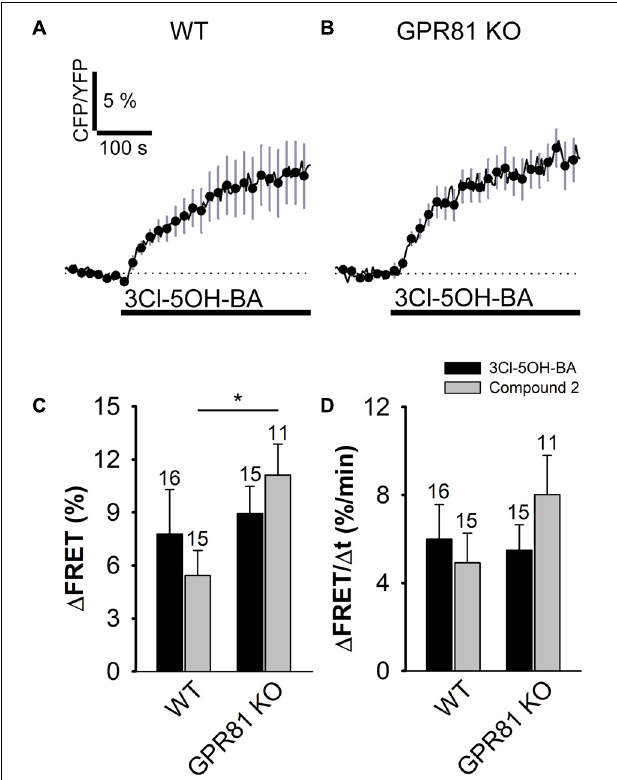
FIGURE 2 | Stimulation with 3Cl-5OH-BA and Compound 2 elicits persistent increase in [cAMP] i in WT and GPR81 KO mice astrocytes expressing the FRET nanosensor Epac1-camps. (A,B) Mean normalized time-courses of the Epac1-camps FRET ratio signal after stimulation with 3Cl-5OH-BA (0.5 mM) in (A) WT ( n = 16) and (B) GPR81 KO ( n = 15) cultured mouse astrocytes at t = 100 s (black lines). Changes in the FRET ratio signal are expressed as percentages of the inverse FRET ratio signal (CFP/YFP) relative to the baseline values. The monophasic exponential increase in the FRET signal (represented by the CFP/YFP ratio) after 3Cl-5OH-BA stimulation reflects an increase in [cAMP] i . Each data point represents mean ± s.e.m. (C,D) Mean changes in the Epac1-camps FRET ratio signal ( (cid:49) FRET; C ) and initial rates of the FRET ratio signal increase ( (cid:49) FRET/ (cid:49) t; D ) after the addition of 3Cl-5OH-BA (black bars) and Compound 2 (gray bars) in WT and GPR81 KO astrocytes. Numbers by the error bars depict the number of cells analyzed. ( ∗ P < 0.05; Mann Whitney U test) Data for every set of experiment was acquired from at least two different animals except for Compound